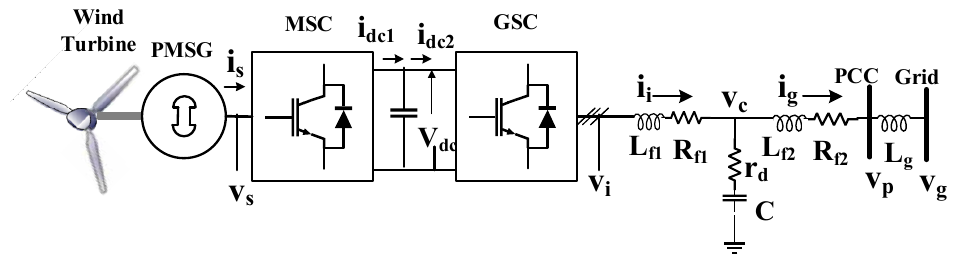
Figure 1. System under consideration .